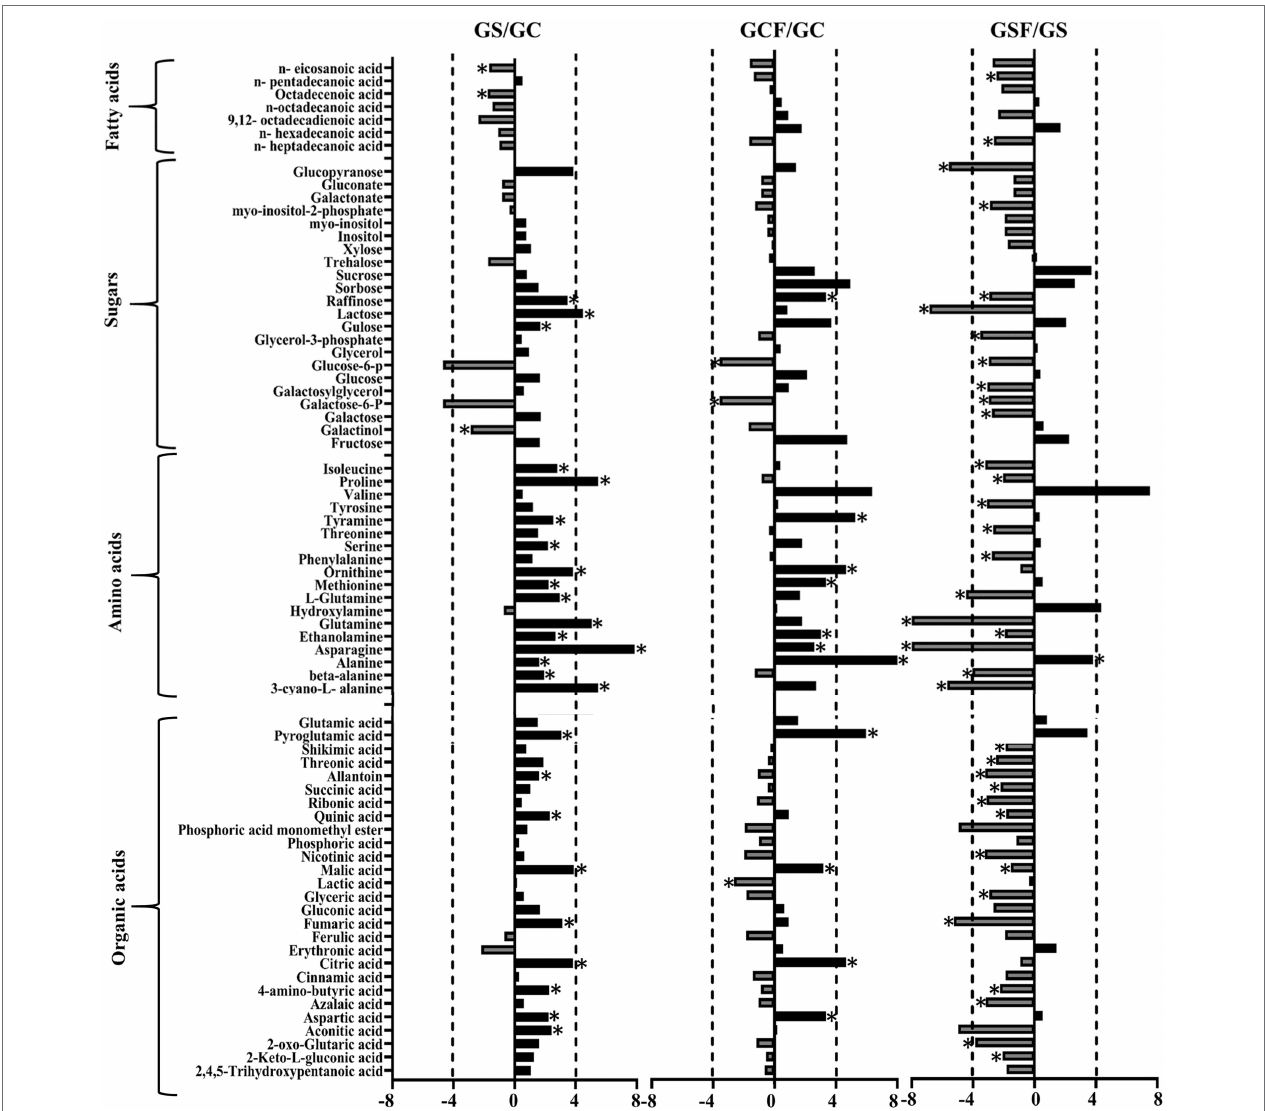
FIGURE 6 | The graphs represent salt grown vs. control grown (GS/GC); control with fungus vs. control grown (GCF/GC); and salt with fungus vs. salt grown (GSF/ GS) logarithmic ratios of representative sugars, organic acids, and amino acids in roots of barley cv. Gairdner (G). An asterisk (*) indicates that the values are significantly different ( p < 0.05, FDR). A dashed line indicates a four-fold change